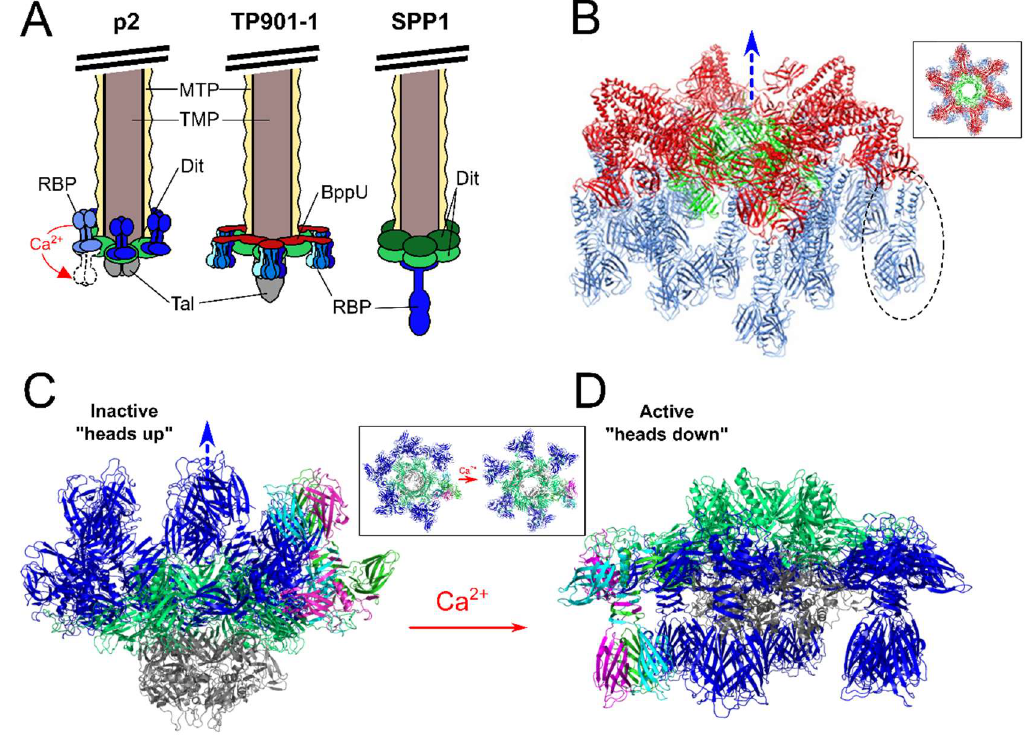
Figure 4. Divergent baseplate architectures of Gram-positive-targeting Siphoviridae phages. ( A ) Simplified models of the baseplates from saccharide (pellicle) binding L. lactis phages p2 and TP901- 1 and protein (YueB) binding B. subtilis phage SPP1. Highlighted is the Ca 2+ activation trigger that induces flipping of RBP trimers to an active state for phage p2. ( B ) Ribbon representation of the TP901- 1 baseplate (PDB ID: 4V96 [18]), reproduced with permission from PNAS, Veesler et al. (2012) [18]. The baseplate consists of a central Dit hexamer (green) connected to six copies of trimeric BppU (red). Attached to the end of each BppU are three trimeric RBP complexes (blue), making 54 individual RBP monomers. Missing is the distal Tal complex that would attach to the bottom of the baseplate. A single RBP trimer is highlighted with a dashed circle. Inset box shows the baseplate rotated by 90° around the horizontal axis to provide a view through the tail tube. Compared to the p2 baseplate, there is no conformational changes to the TP901-1 RBP positioning as they are already in an “active state” that is ready for host recognition. ( C , D ) Ribbon representations of the p2 baseplate in the inactive state with RBPs in the “heads up” position (PDB ID:2WZP [16]). ( C ), and then switched to the “active” state with RBPs flipped 200° into the “heads down” position (PDB ID: 2X53 [16]) ( D ). The p2 baseplate contains a hexameric ring of Dit (green); trimeric Tal (grey); and six trimeric complexes of RBP (blue). The three chains of a single RBP complex are colored green, magenta, and cyan. Box insets show the baseplate rotated by 90° around the horizontal axis to present a top down view through the tail tube. Blue arrow points along axis towards the phage tail and capsid in ( B – D ).